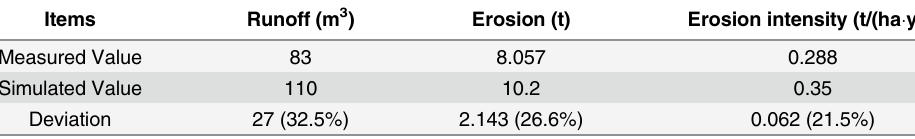
Table 3. WEPP model performance using small catchment